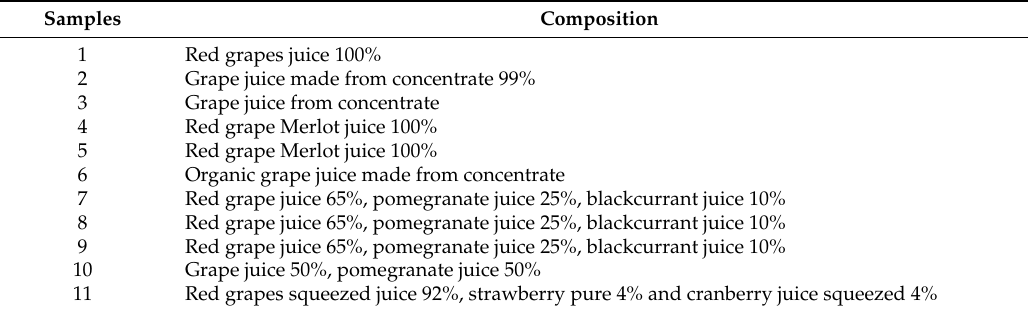
Table 4. Composition of grape juices.